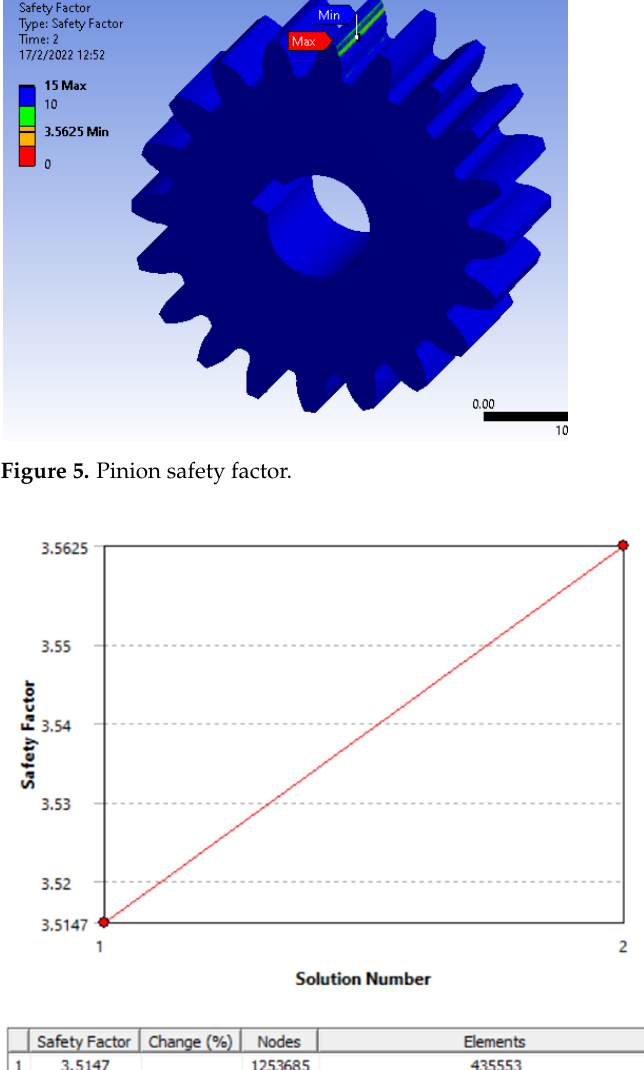
Figure 5. Pinion safety factor.